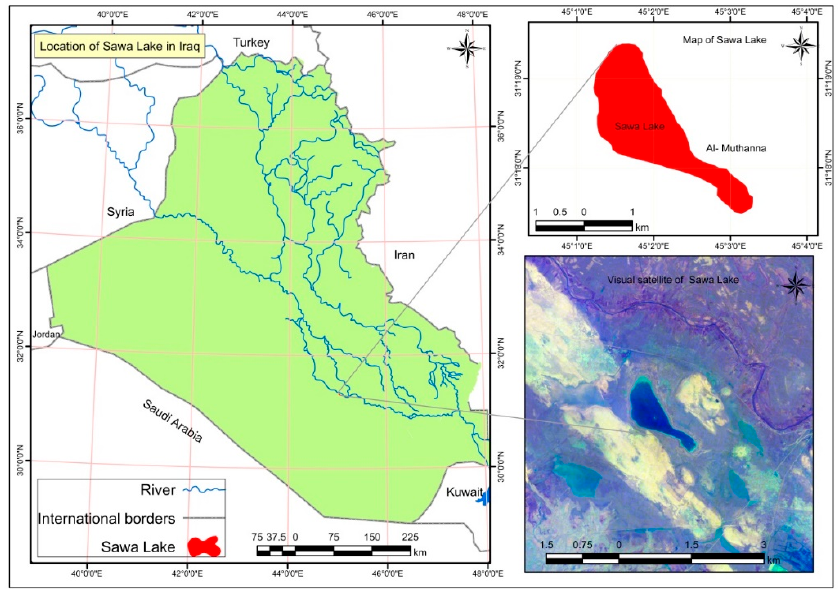
Figure 1. Map of Sawa Lake, Iraq.